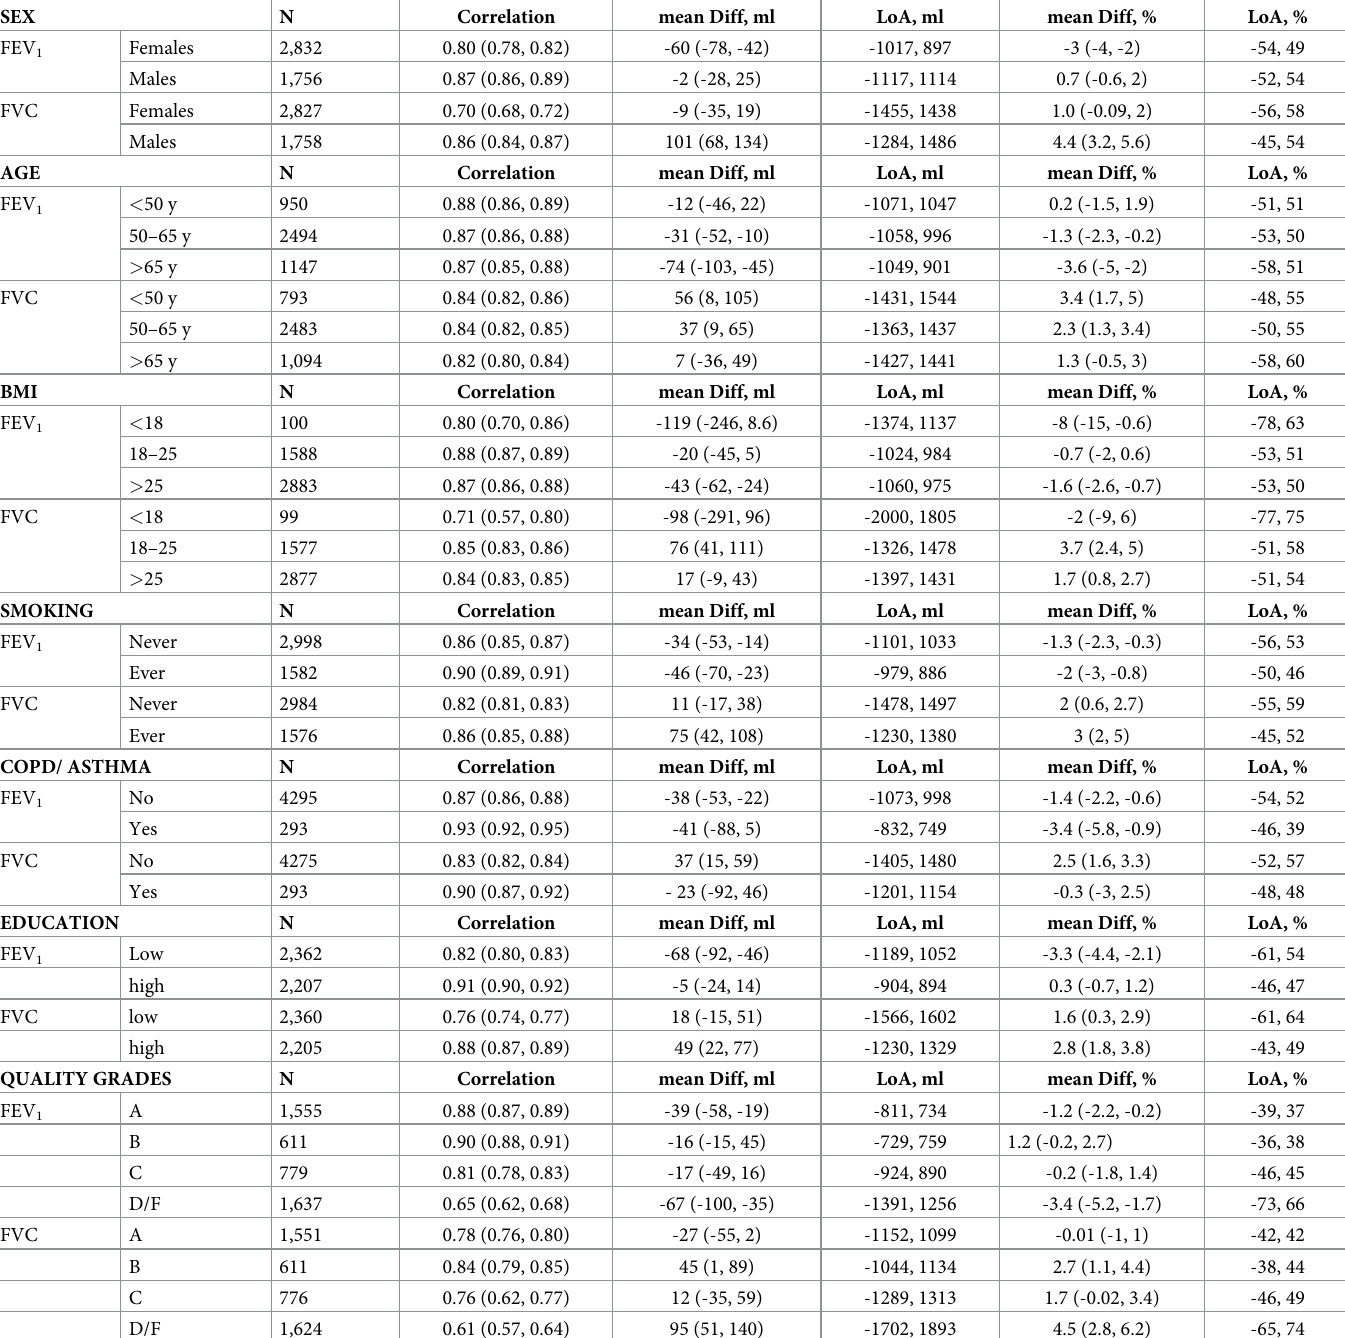
Table 4. Stratified analyses by demographic, anthropometric, clinical characteristics and quality